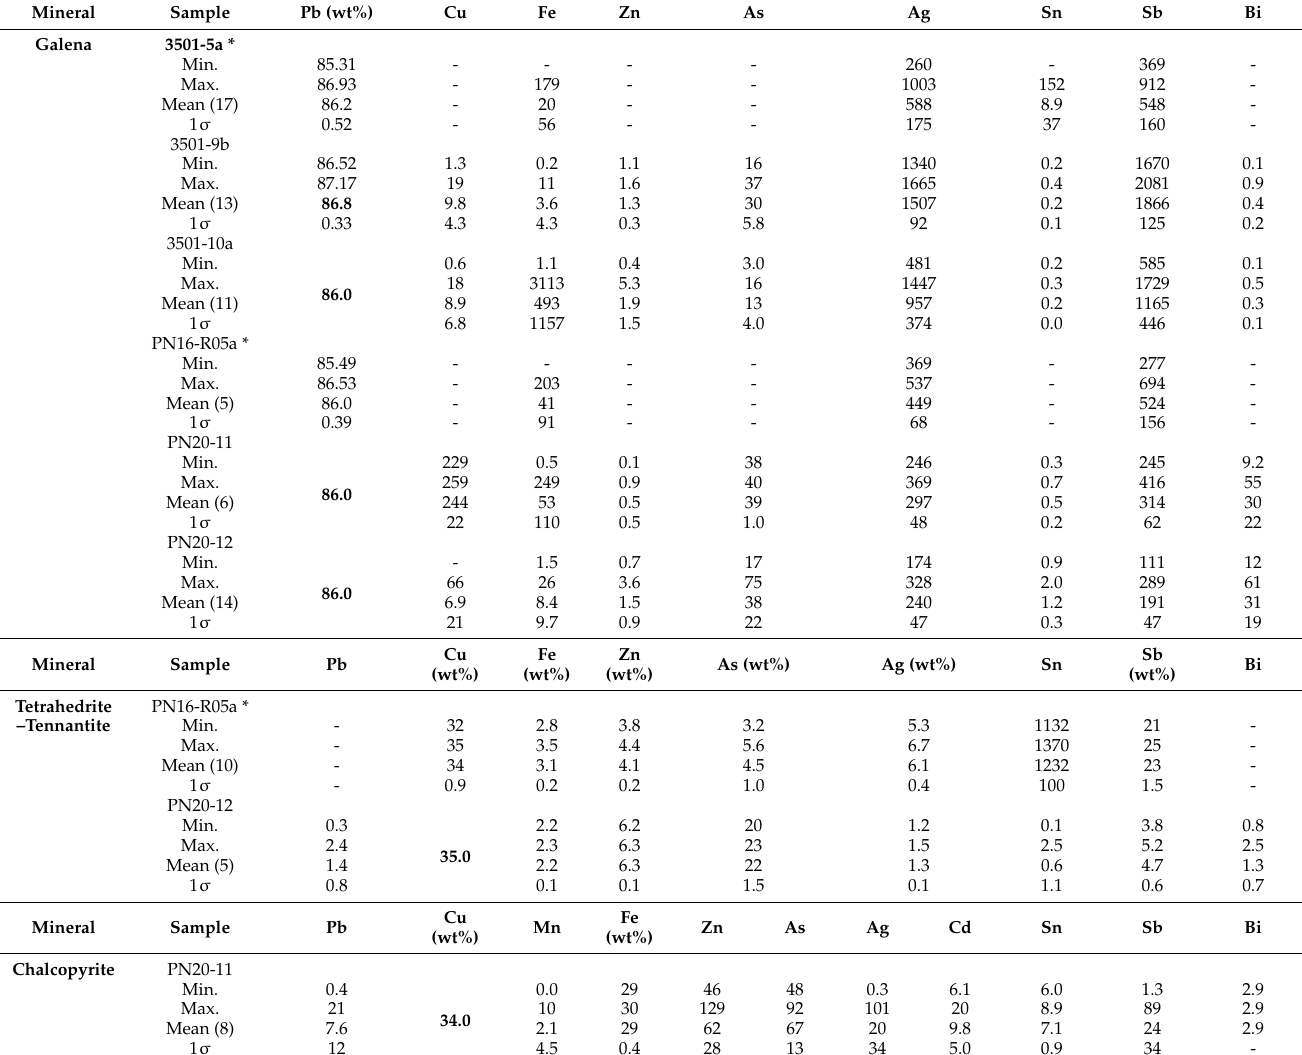
Table 1. Sulfides–sulfosalts major element concentrations determined by EPMA in wt%, and trace elements by LA-ICP-MS in